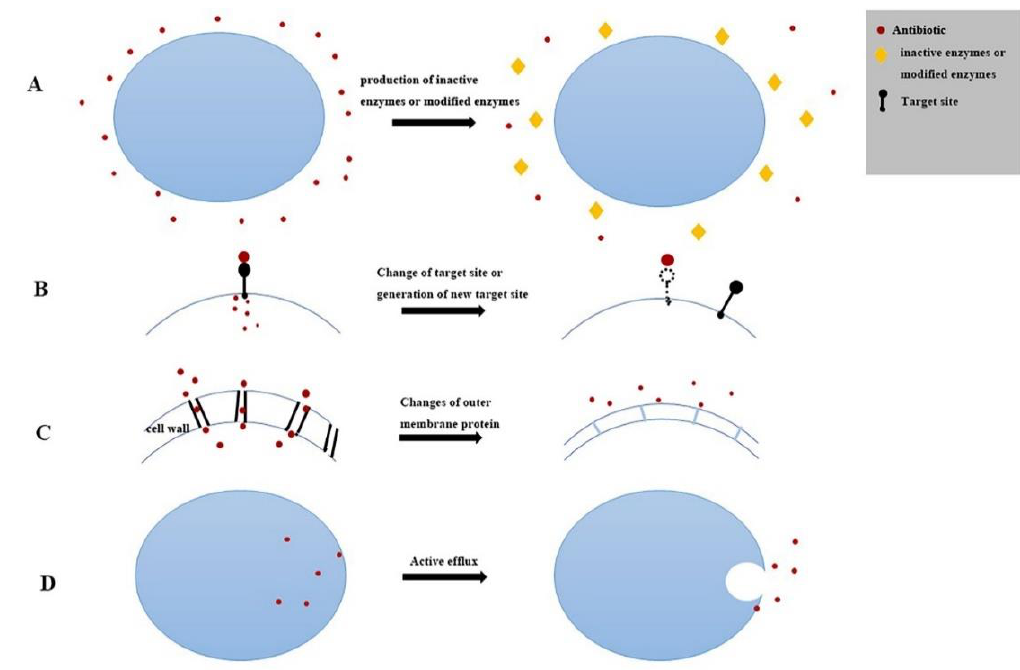
Figure 7. Biochemical (protein) mechanism. ( A ) Production of inactivated or modified enzymes. ( B ) Change of target site or generation of new target site. This makes is di ffi cult for antibiotics to bind to cells, thus reducing the inhibitory e ff ect of antibiotics. ( C ) Changes of outer membrane protein. Long-term drug e ff ects can stimulate adventitia proteins to alter the cell wall structure and reduce permeability, thus hindering the penetration of antibiotics. ( D ) Active e ffl ux system. When energy is available, membrane proteins selectively or non-selectively expel antibiotics from the cell, reducing drug concentration and leading to drug resistance.